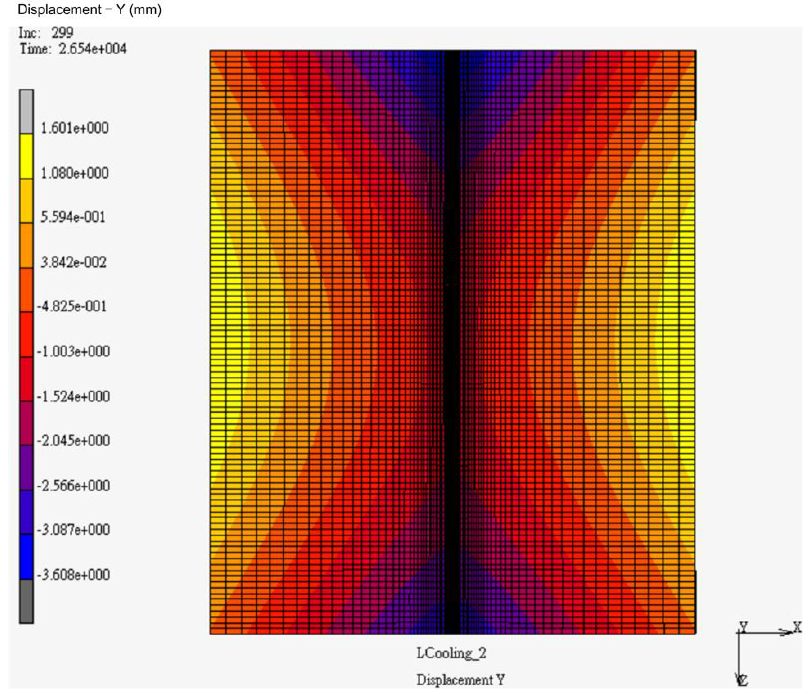
Figure 10. Gas metal arc welding (GMAW) welding deformation without jigs after cooling to 25 °C.